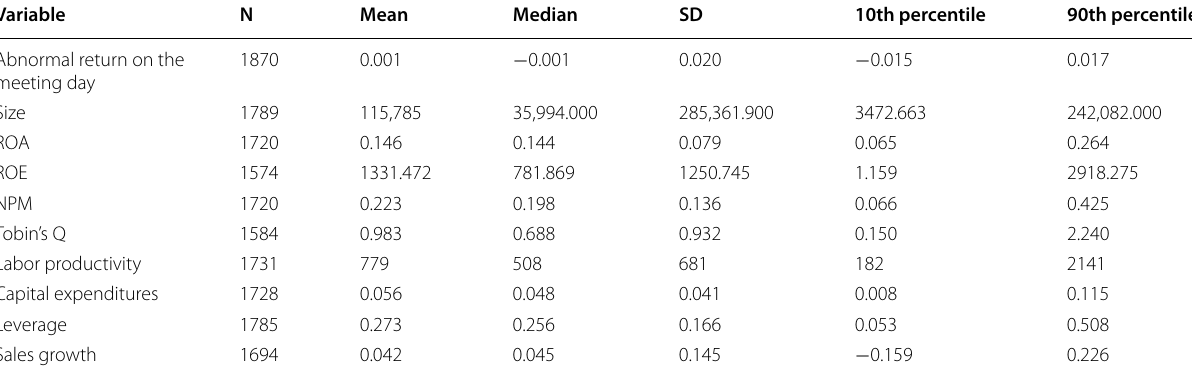
Table 3 Summary